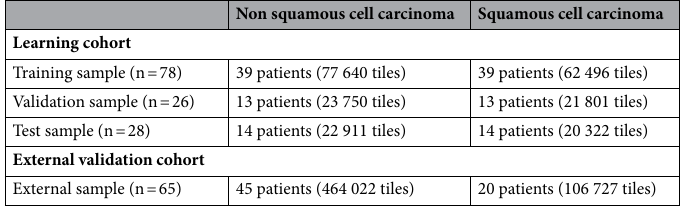
Table 1. Description of learning and external validation cohorts.